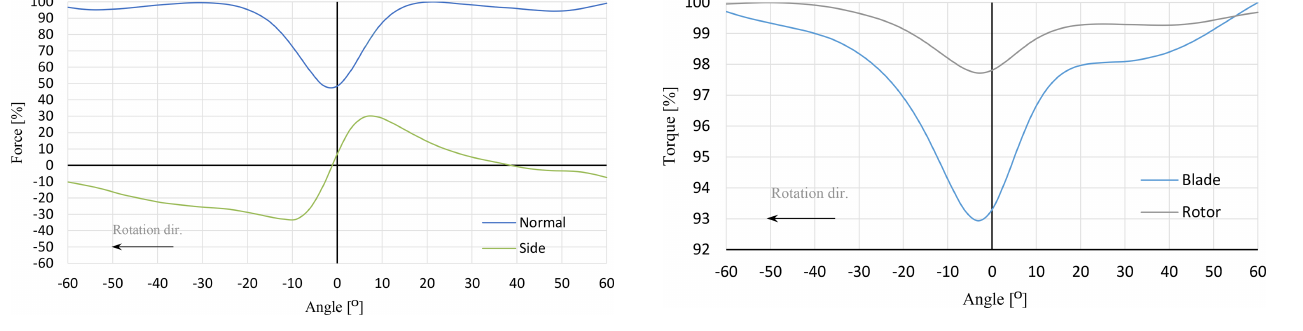
Figure 9. Single blade and rotor torque for one-third